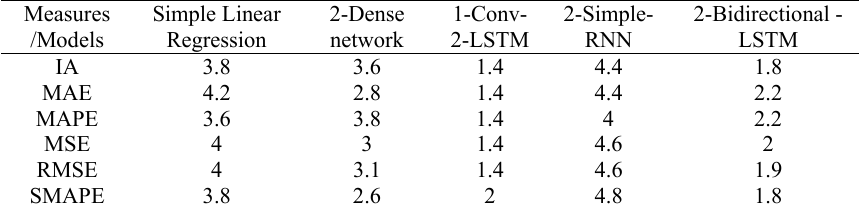
Table 8. Average rank based on performance evaluation measures for all models on all five